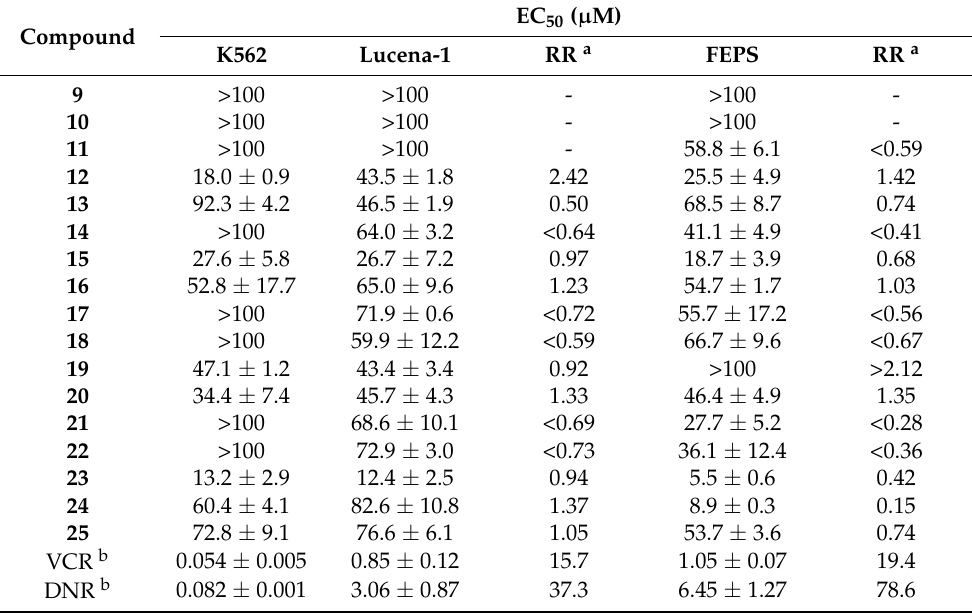
Table 2. Antiproliferative activity of compounds 9 – 25 against drug-resistant CML cell lines. EC 50 ( µ M) Compound K562 Lucena-1 RR a